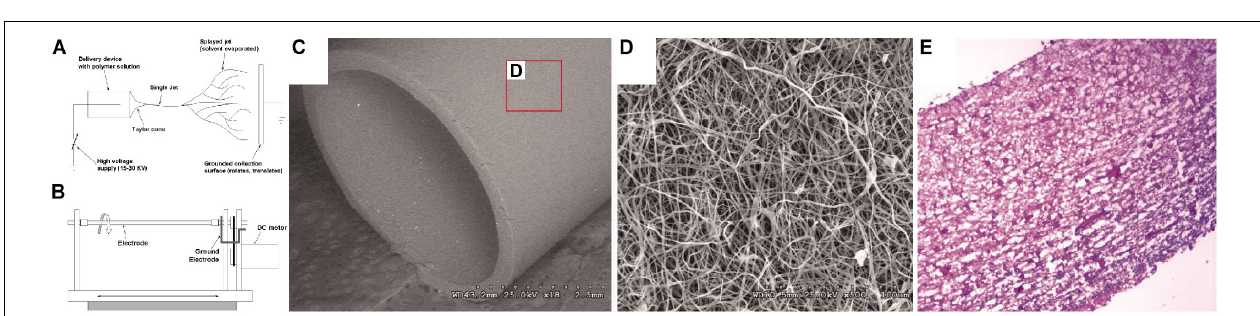
FIGURE 4 | Example of electrospinning process for manufacturing a tubular scaffold for vascular tissue engineering (Lee et al., 2007). (A) Schematic of electrospinning process. (B) Schematic of spinning mandrel for tubular scaffold production. (C) SEM image of bulk scaffold, produced from collagen, elastin, and polymeric mixture, at 18x magnification. (D) SEM image of scaffold from inset in (C) at 500x magnification. (E) Hematoxylin and eosin histological stain of scaffold seeded with smooth muscle cells. Images were reordered from multiple panels, and lettering has been relabeled for consistency as part of this review article (Lee et al.,